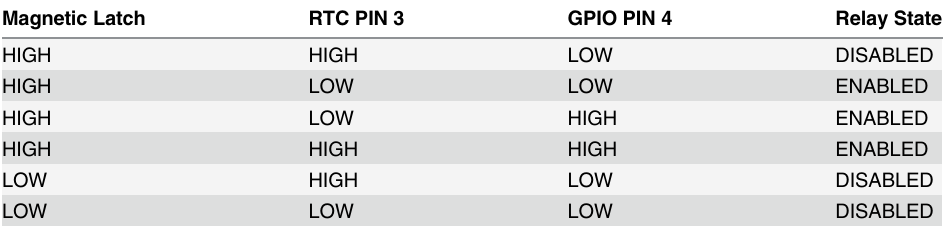
Table 1. Truth table showing the resulting state of the logic driver circuit. Magnetic